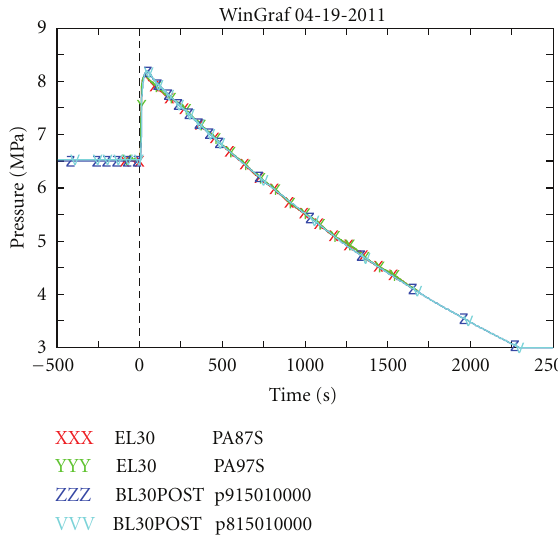
Figure 4: Primary system pressure.